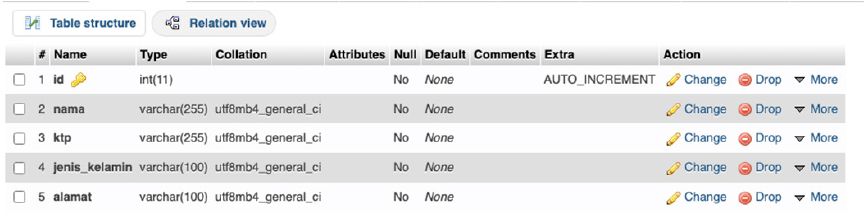
Fig. 2. Table structure